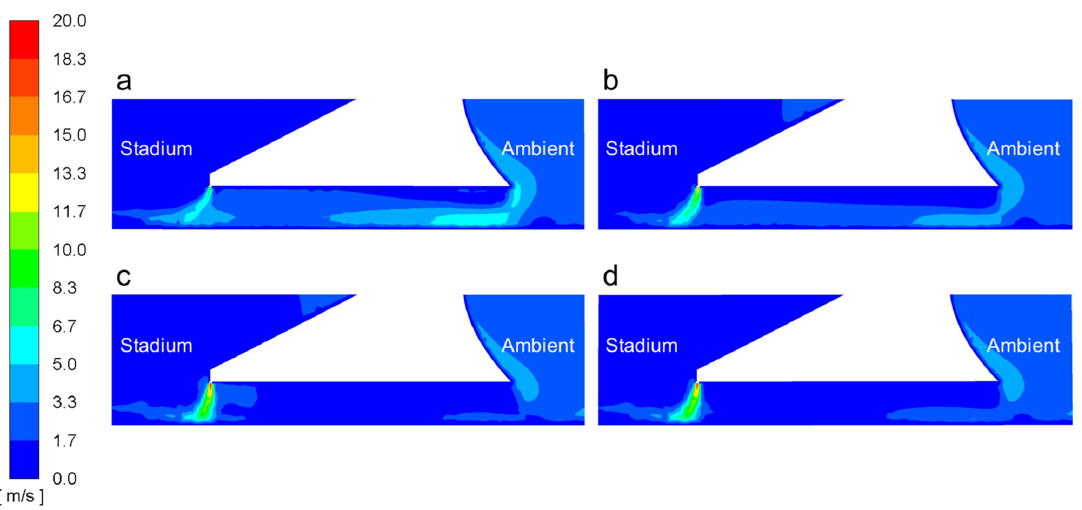
Figure 12. ( a – d ) Wind velocity contours of gateway A for scenarios one to four.